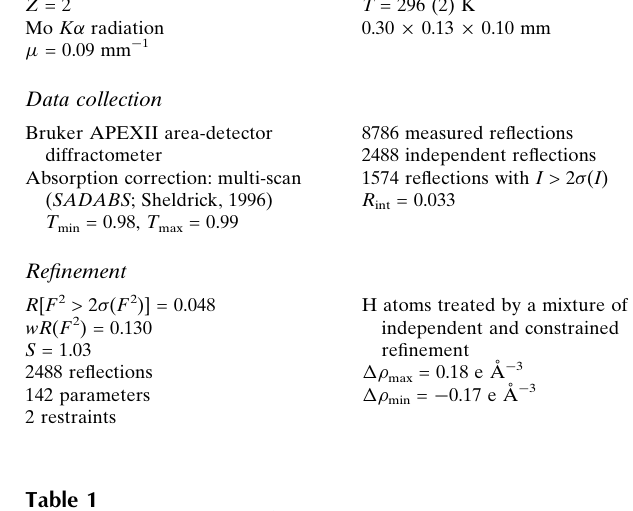
Hydrogen-bond geometry (A˚ , (cid:2)